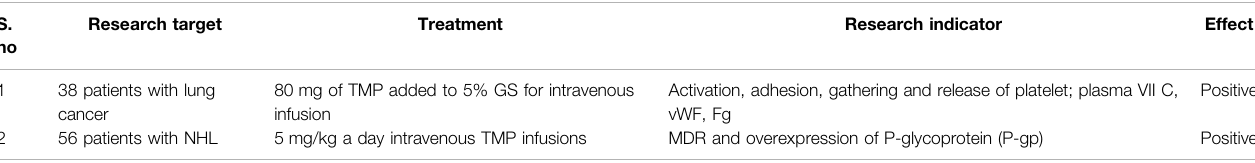
TABLE 1 | Clinical application of tetramethylpyrazine (TMP) in cancer